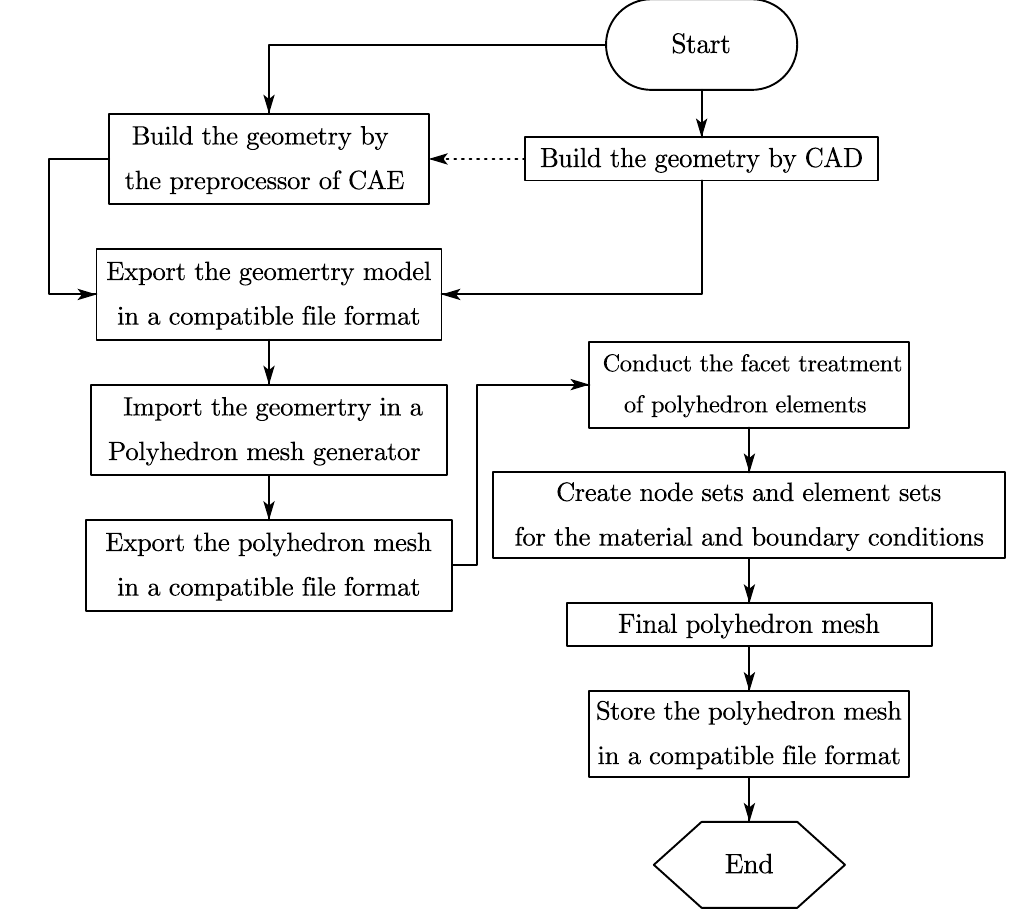
Figure 7. General procedure of SBFEM polyhedron mesh generation by out-of-box